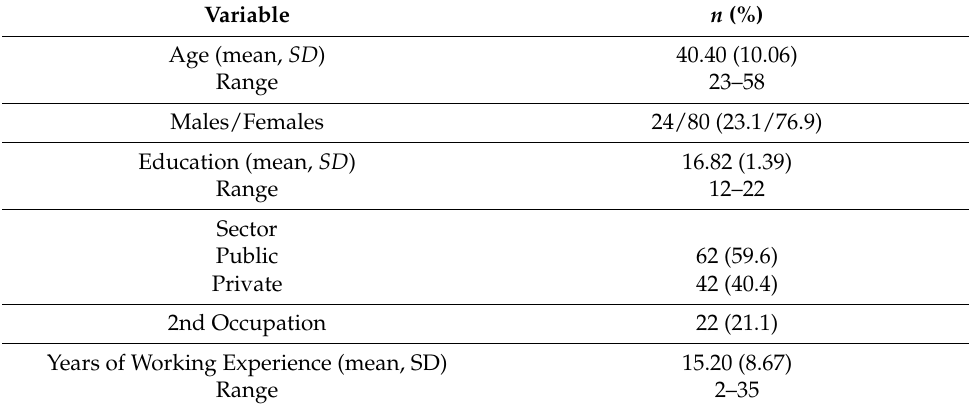
Table A2. Sample Description ( n =